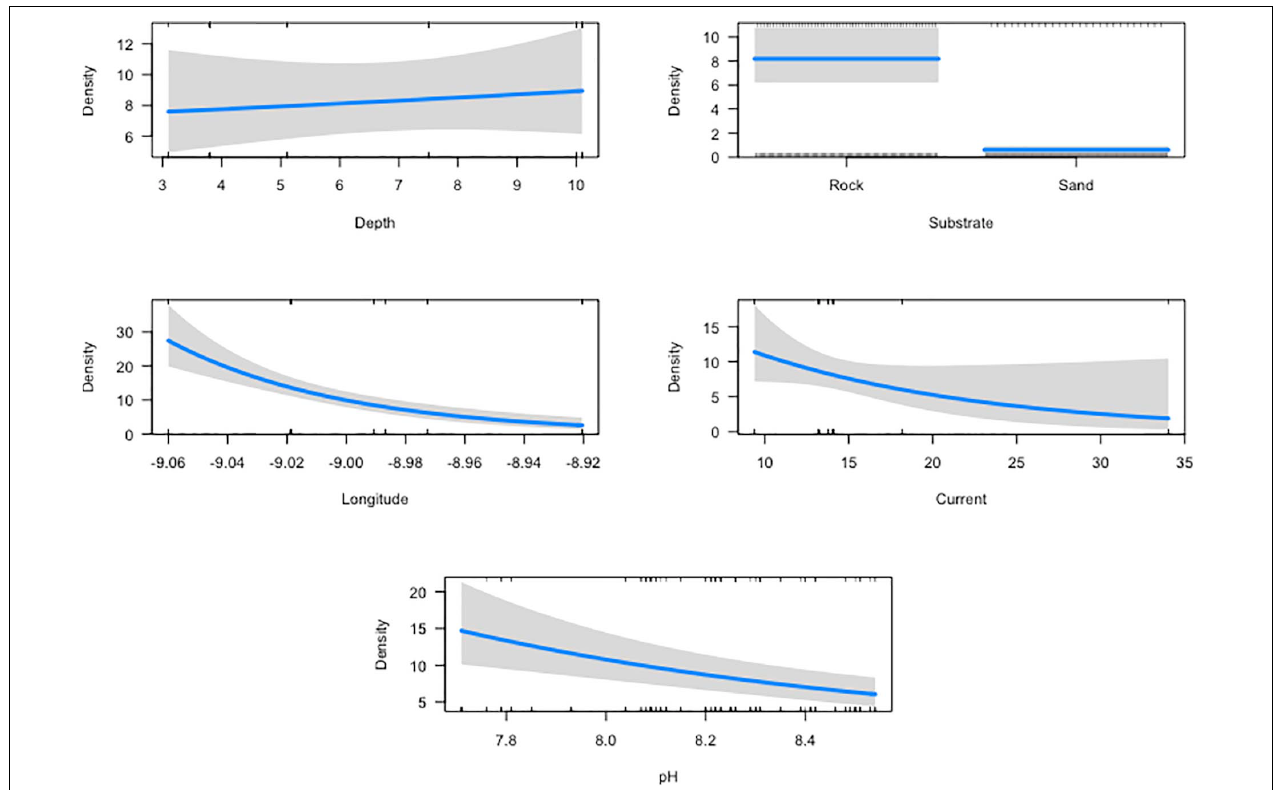
FIGURE 6 | Partial plots of the density model for all significant predictors – Fixed-effect GLM with a Tweedie distribution – explaining distribution patterns of Holothuria mammata at Arrábida, Setúbal.